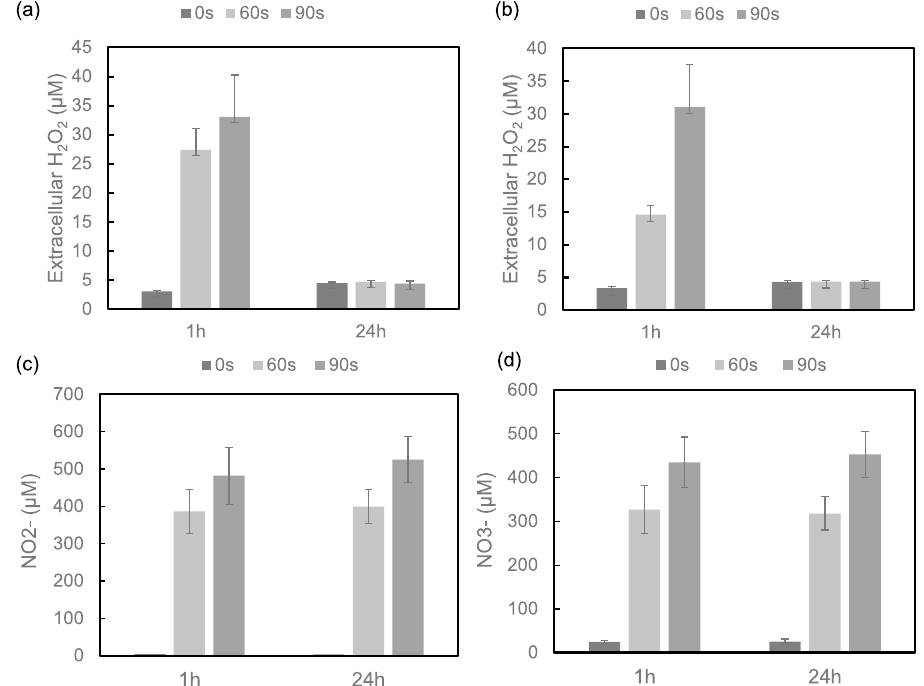
− − and NO 3 levels in cell culture media after plasma treatment − − 3 ( d ) in Jurkat cell 2 ( c ) and NO